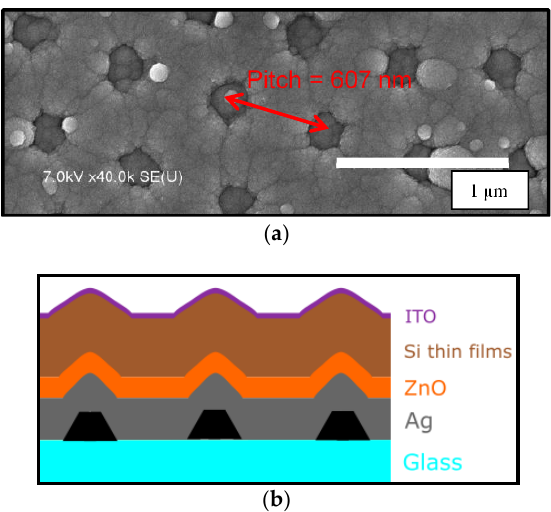
Figure 2. ( a ) Top view SEM image of the complete solar cell and ( b ) Schematic cross section of a hexagonal back reflector solar cell.